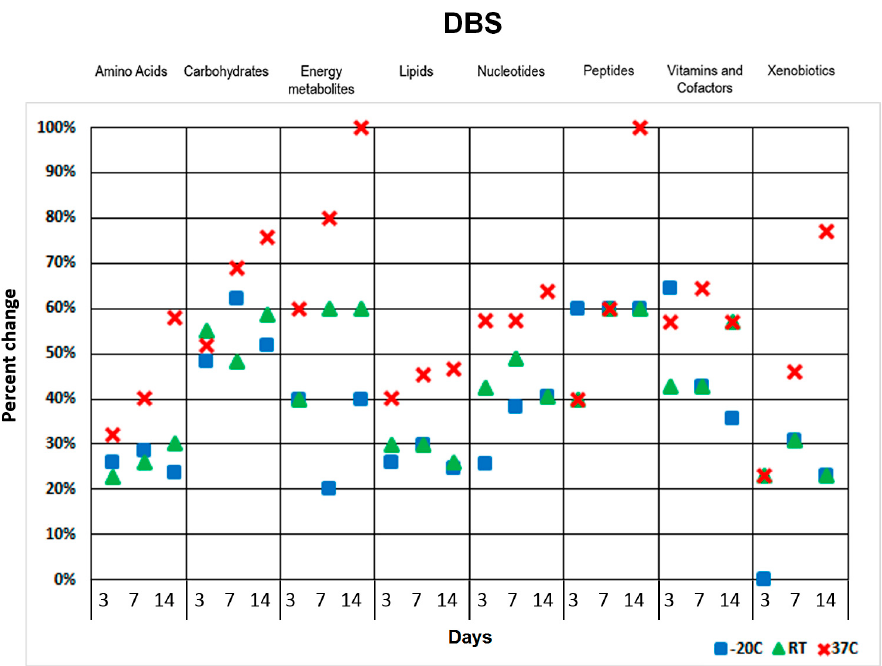
Figure 2. Two weeks DBS storage stability results for detected human blood metabolite classes assigned by participation in major pathways. Y axis represents percent change calculated using the mean of triplicate measurements for a metabolite class. Each column shows three measurement points at 3, 7 and 14 days (from left to right).